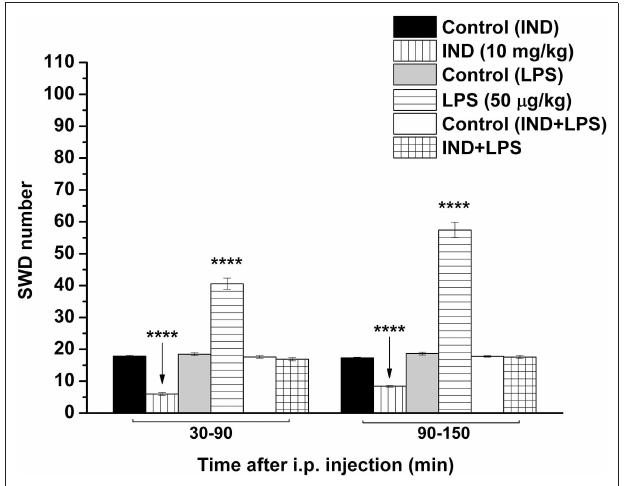
FIGURE 4 | The effect of combined administration of KEKS food (20% KEKS and 1% saccharin in standard rodent chow) with IP LPS (50 µ g/kg) on SWD number on the day of 9th KEKS food administration (9K + L; group 5). 1K, 1st KEKS food administration; 2K, 2nd KEKS food administration and so on; 9K + L, combined administration of KEKS food (K) with i.p. LPS (L) on the day of 9th KEKS food administration; CON, control; SWD, spike-wave